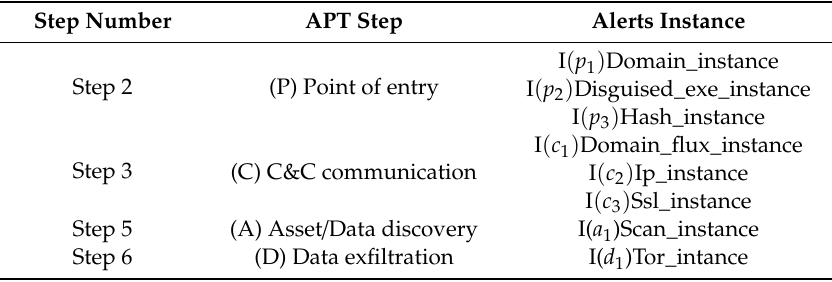
Table 4. The matchup between APT attack scenario steps and alert